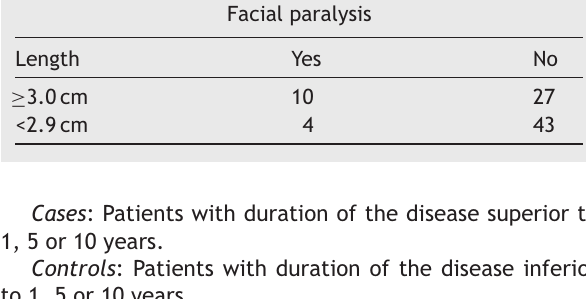
Case-control table --- tumor’s length. Facial